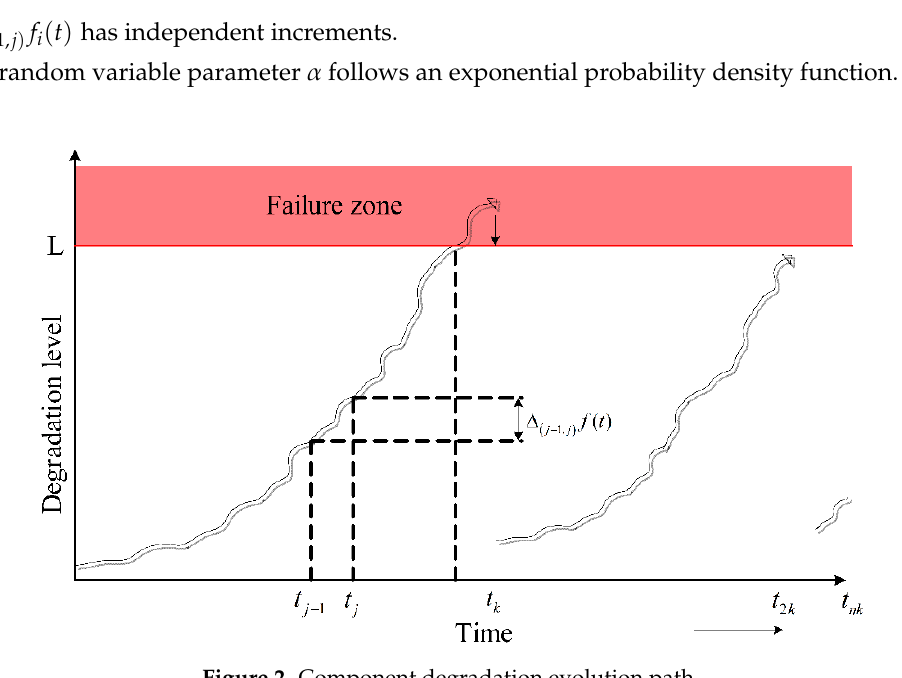
Figure 2. Component degradation evolution path.